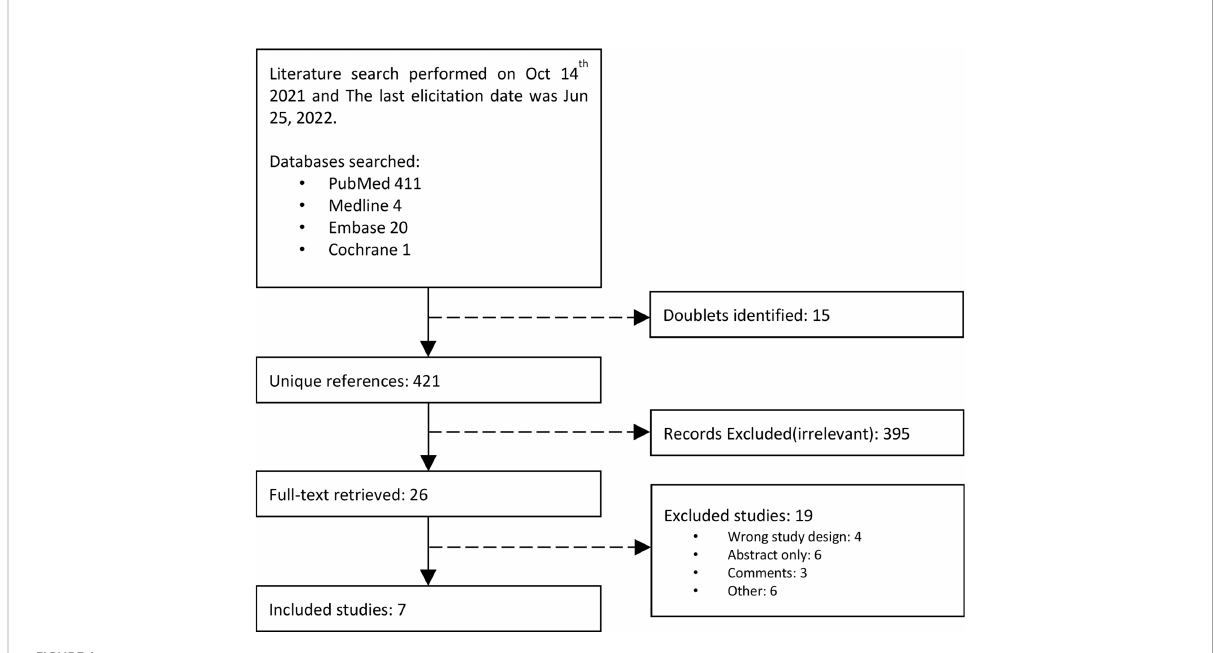
FIGURE 1 Flow diagram of literature